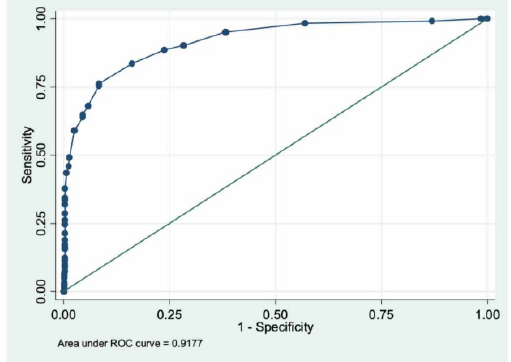
Figure 3. Receiver Operating Characteristic (ROC) curve for CFI linked to the probability of undergoing surgical procedures lasting up to 240 min. Area Under the Curve (AUC) = 0.92 (95%IC 0.89–0.95). Table 3. Statistical results using CFI score ≥ 10 as higher cutoff.